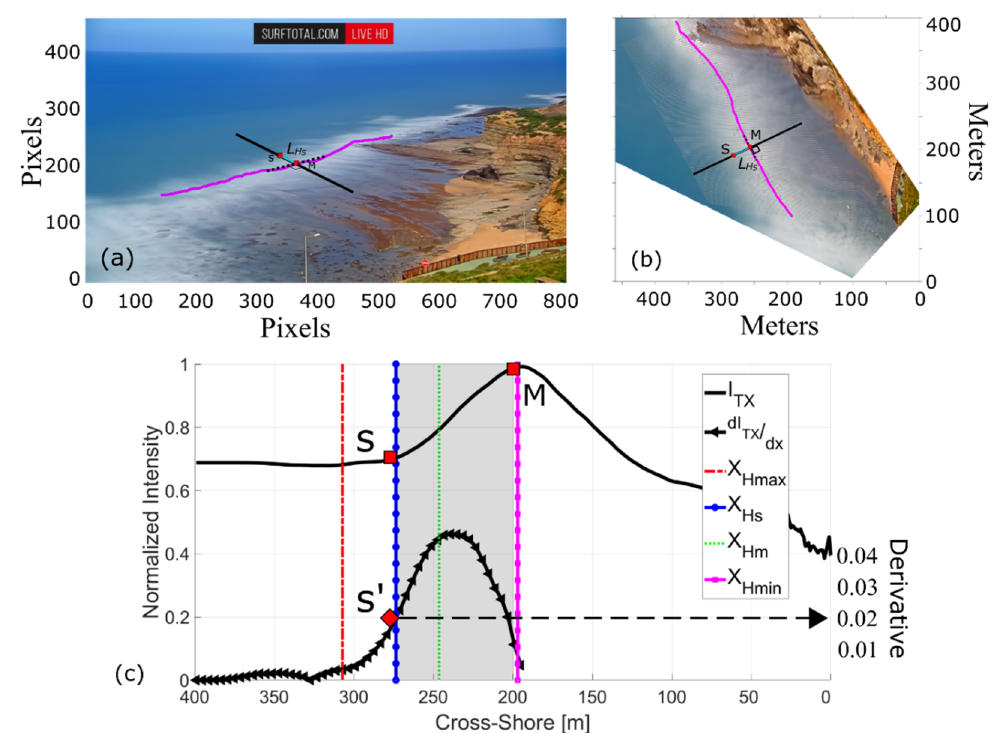
Figure 5. Automated algorithm for deriving L Hs from I px and I TX pixel intensity profiles. ( a ) Oblique Timex and ( b ) portion of rectified Timex with detected breakline (magenta line), 10-m long portion of breakline (dashed black line), and perpendicular transect used to extract I TX (which correspond to I px ). Red squares show points S and M found on Timex and the cyan segment is the derived L Hs . ( c ) The procedure to analyze I px and / or I TX profile (black line) and related first derivative (black line with triangles) to extract points S and M. Note the interception (point S’) of the first derivative of I px (and I TX ) (line with triangles) at 0.02 with X Hs cross-shore position. The grey area shows the distance between S and M which corresponds to L Hs